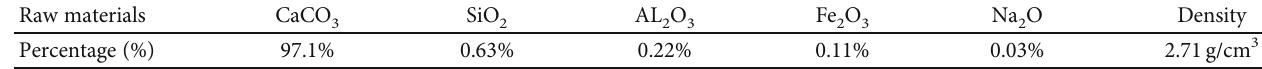
Table 2: Chemical composition of light calcium carbonate.